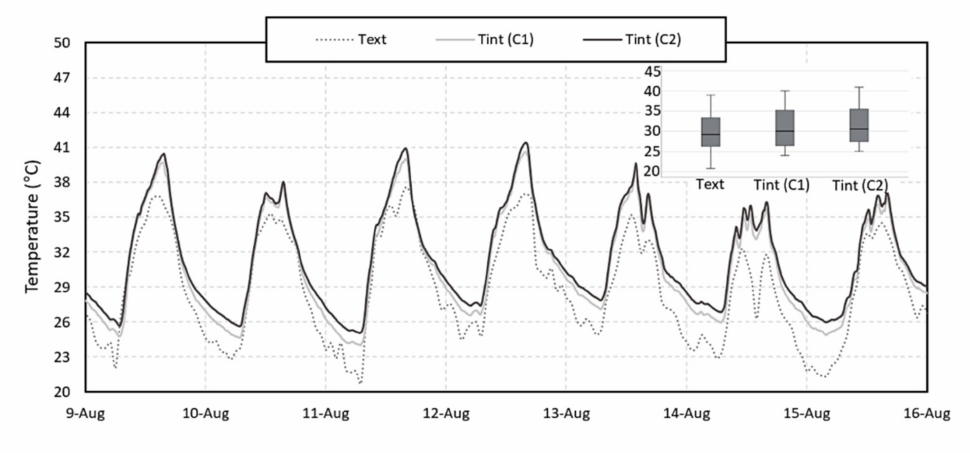
Figure 13. Variation of external and internal temperature in cells C1 and C2 during one week of campaign 3 (natural cross ventilation by wind